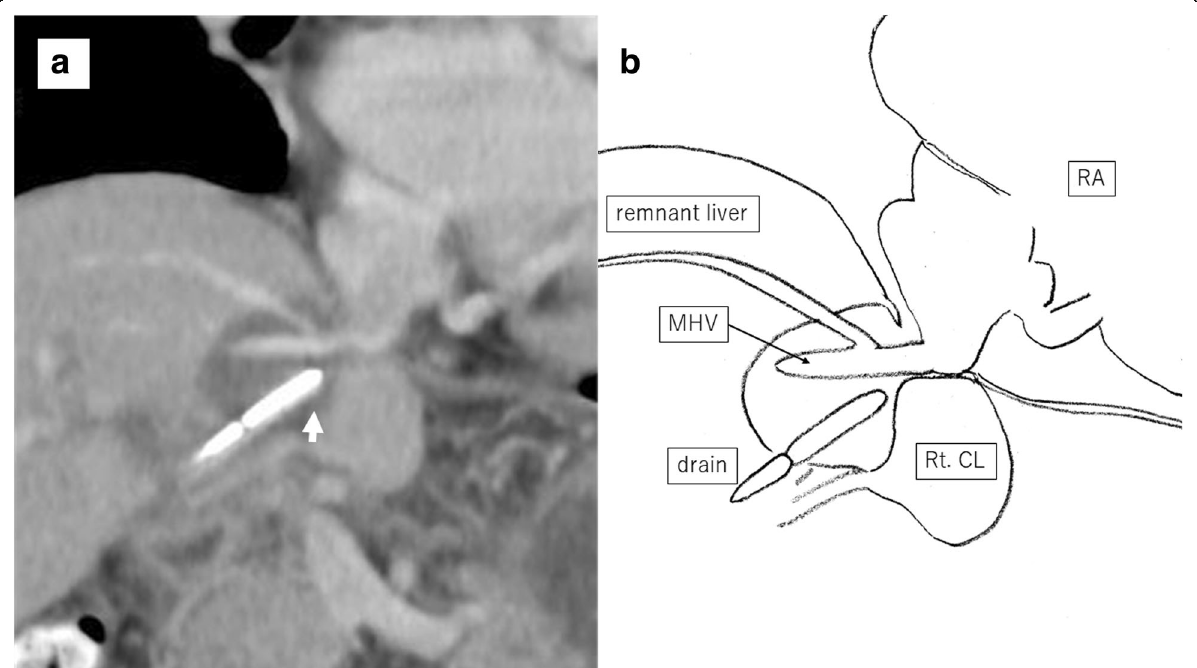
Fig. 2 An enhanced abdominal CT scan before exchanging the drain showed the tip of the drain pointed to the bifurcation of the MHV (arrow, a ). Schema ( b ). MHV middle hepatic vein, Rt . CL right caudate lobe, RA right